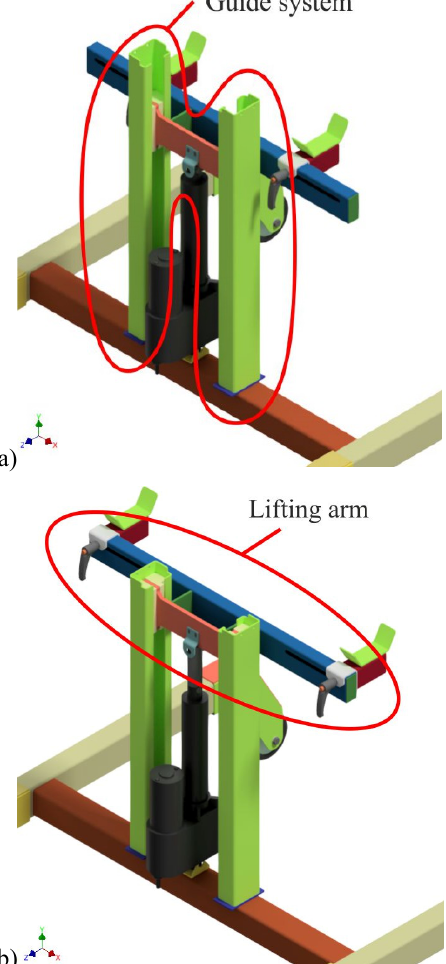
Figure 8. Lifting system: actuator retracted and grips in the closest position (a) and advanced actuator and grips in the expanded position